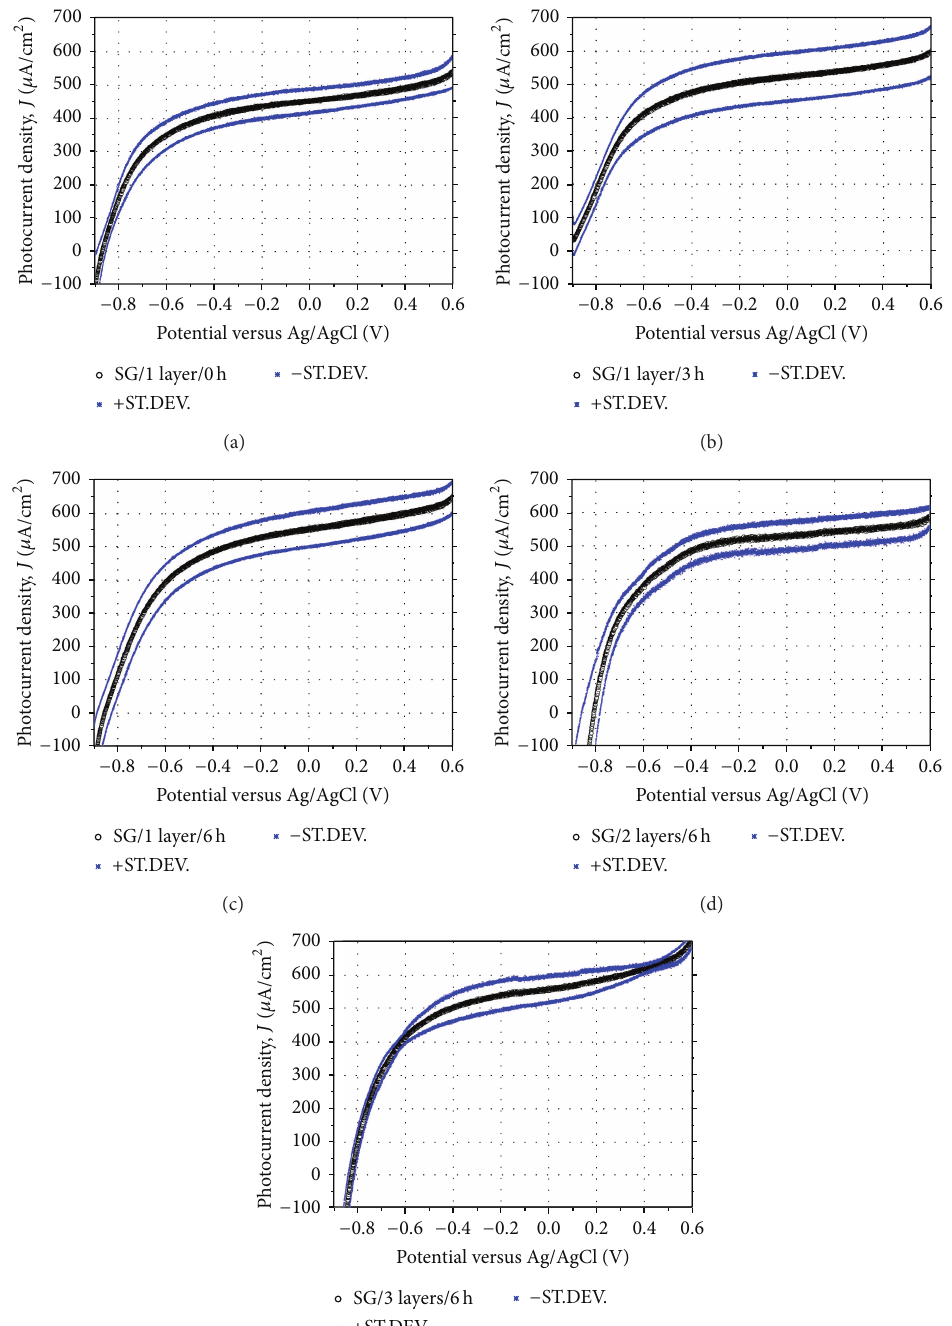
Figure4:EffectofagingtimeonthephotocurrentofTiO 2 sol-gelphotoelectrodes:(a)SG/1layer/0h,(b)SG/1layer/3h,and(c)SG/1layer/6h. The effect of the thickness of TiO 2 on the photocurrent density is also reported; see (d) SG/2 layers/6 h and (e) SG/3 layers/6 h.